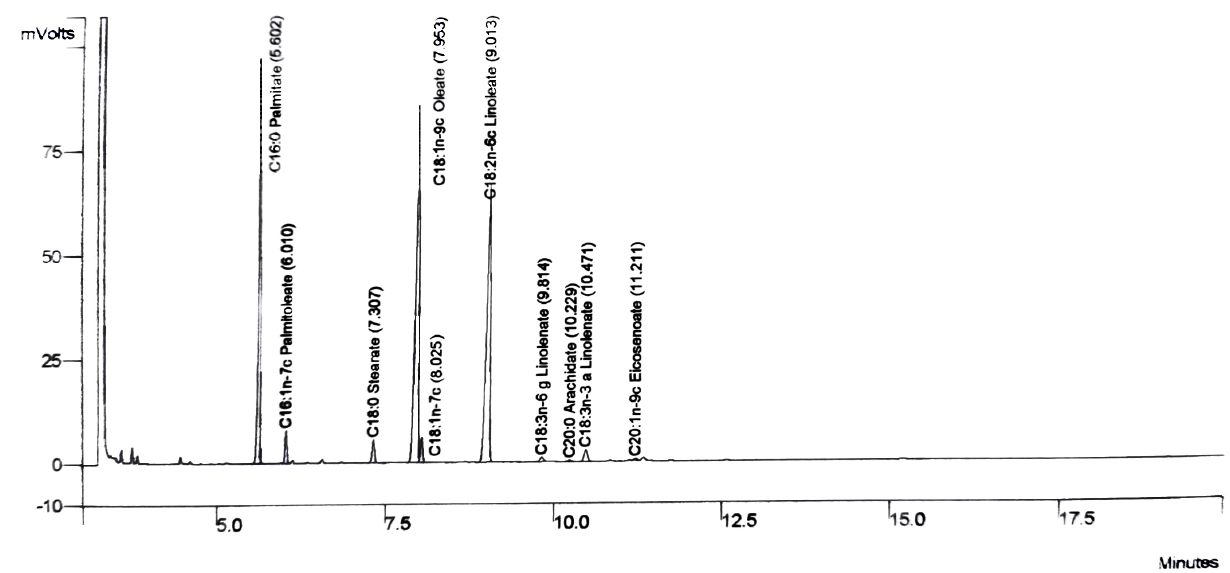
Figure 1. Chromatogram of Fatty Acids from Atlas Pistachio Seeds.